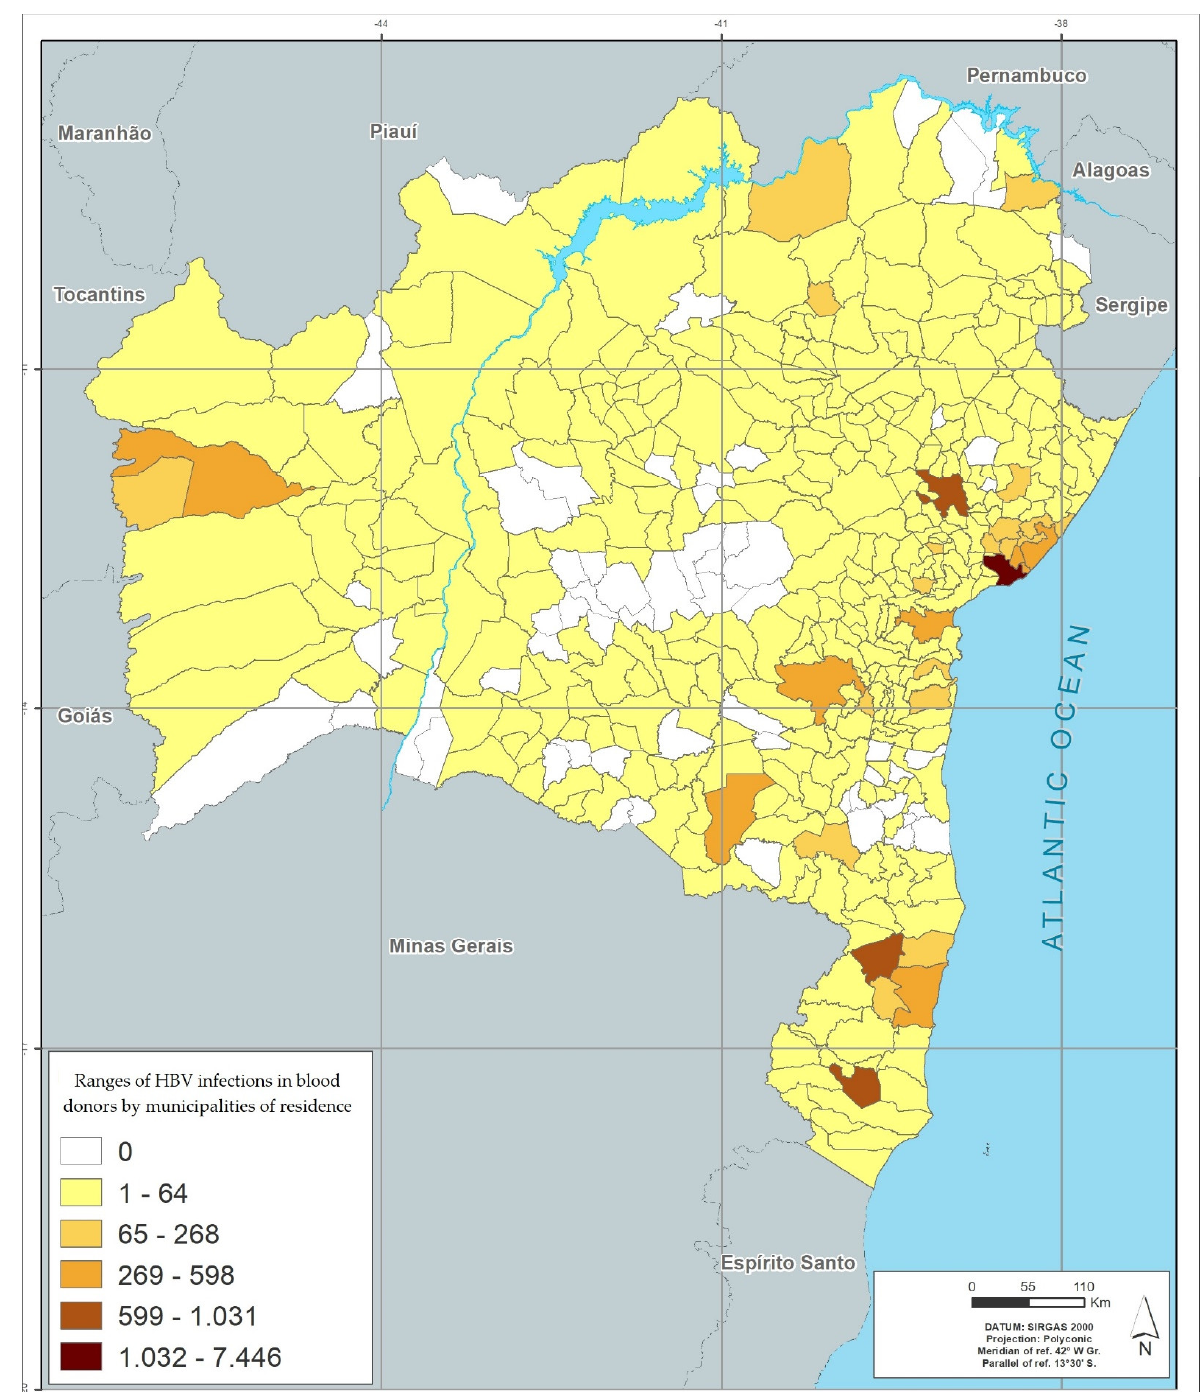
Figure 4. Infection’s rates in absolute numbers for HBV by municipalities of residence in blood do- nors between 2008-2017.